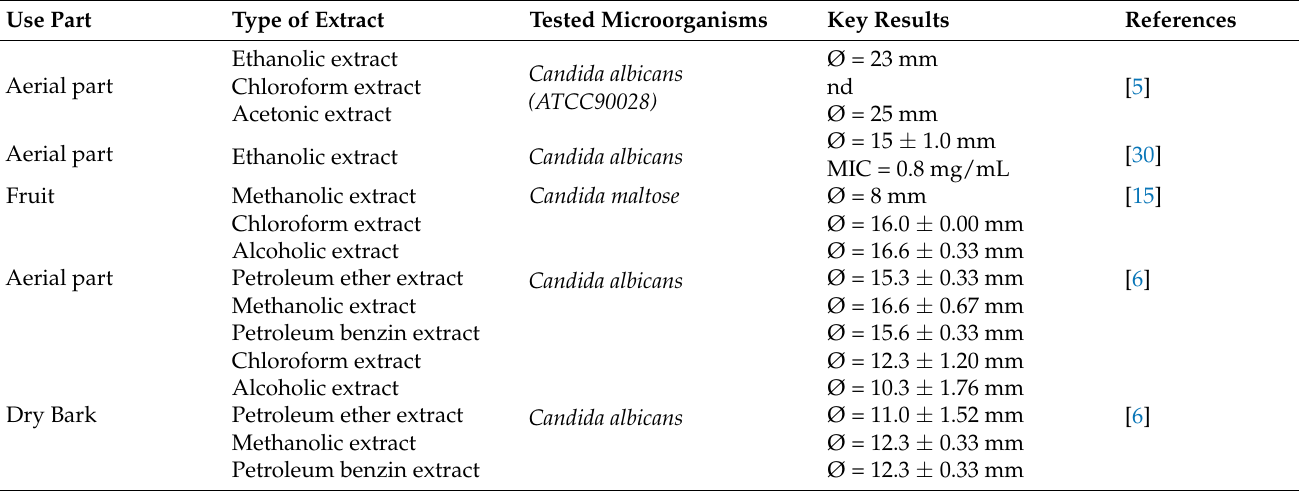
Table 4. Antifungal activity of V. tortilis (none of the references cited below reported control